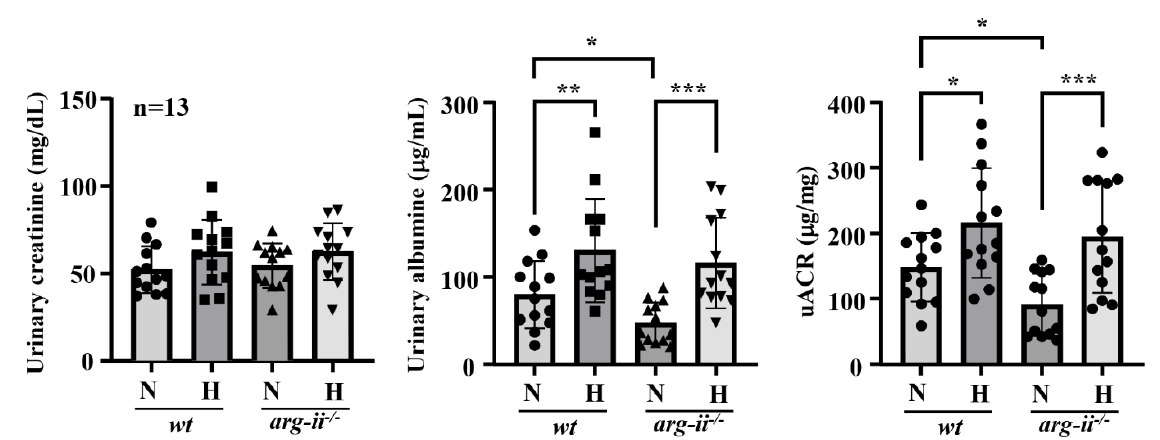
Figure 8. Effect of arg-ii ablation on albuminuria. Urinary creatinine and albuminuria were assessed in 20 to 24 months old mice exposed to normoxia controls or hypoxia (8% O 2 for 24 h). The urinary albumin/creatinine ratio (uACR) was evaluated in wt and arg-ii − / − animals. n = 13 in each group. * p < 0.05, ** p < 0.01, *** p < 0.005 between the indicated groups.